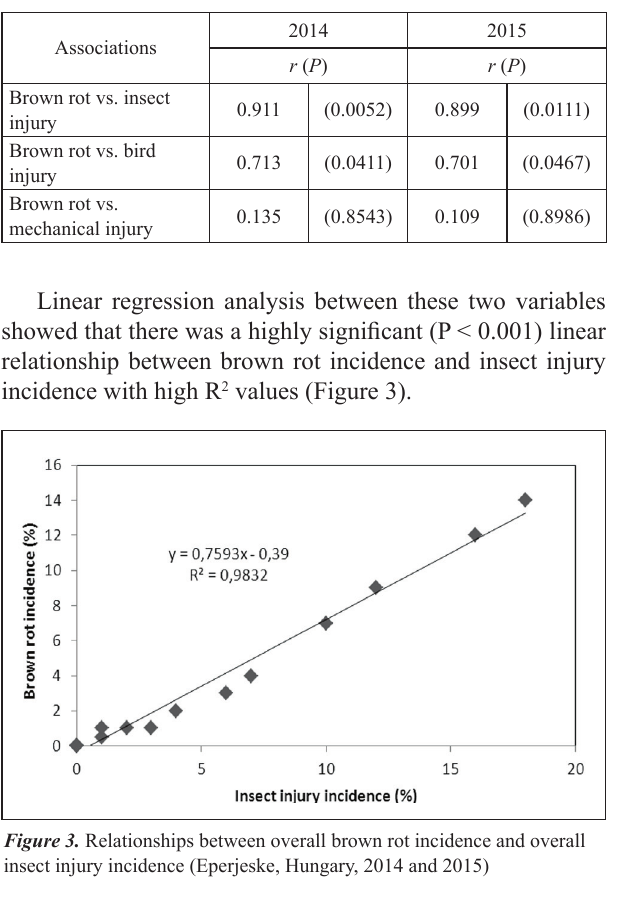
Table 1. Correlation coefficients ( r ) and probability levels ( P ) between brown rot incidence and various injury types in organic apple orchards (Eperjeske, Hungary, 2014–2015).